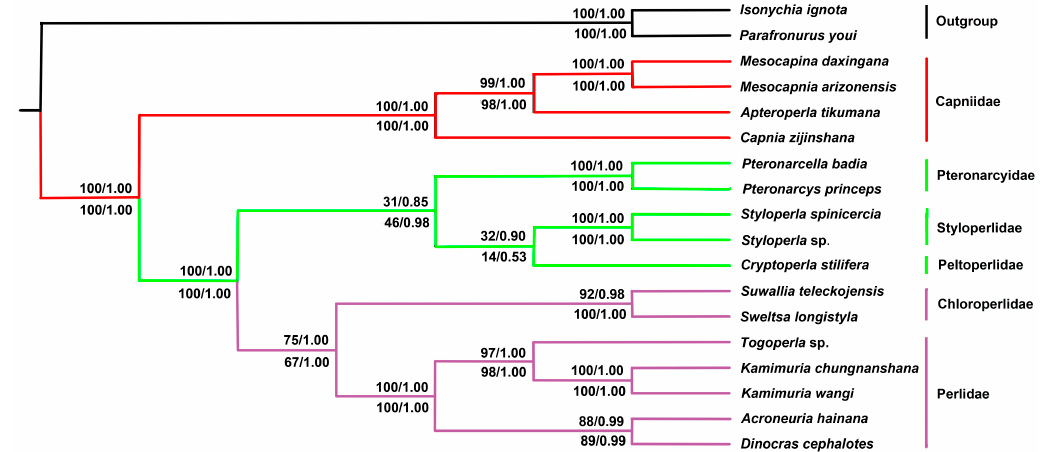
Figure 7. Phylogenetic tree of the 16 sequenced stoneflies. Bayesian inference and Maximum Likelihood Analysis inferred from PCGs and PCGR supported the same topological structure. Values at nodes are ML bootstrap values and Bayesian posterior probabilities using the PCG13 ( up ) and PCGR ( down ) datasets. The tree was rooted with two outgroups ( P. youi and I. ignota ).